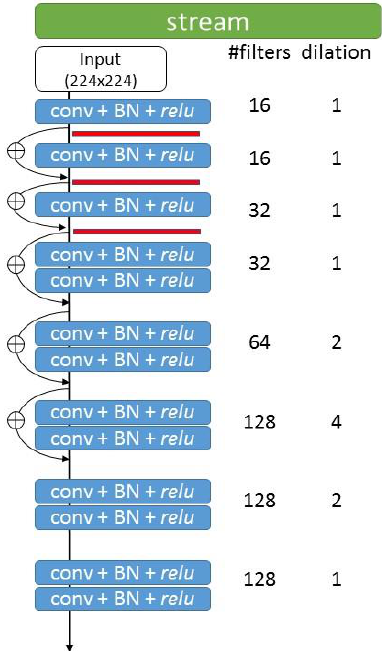
Figure 6. Network used for the mono- and multi-temporal approaches. Residual connections are indicated with a + sign. The red rectangles means that striding of 2 instead of 1 was used. conv stands for convolution + batch normalization (BN) + relu .